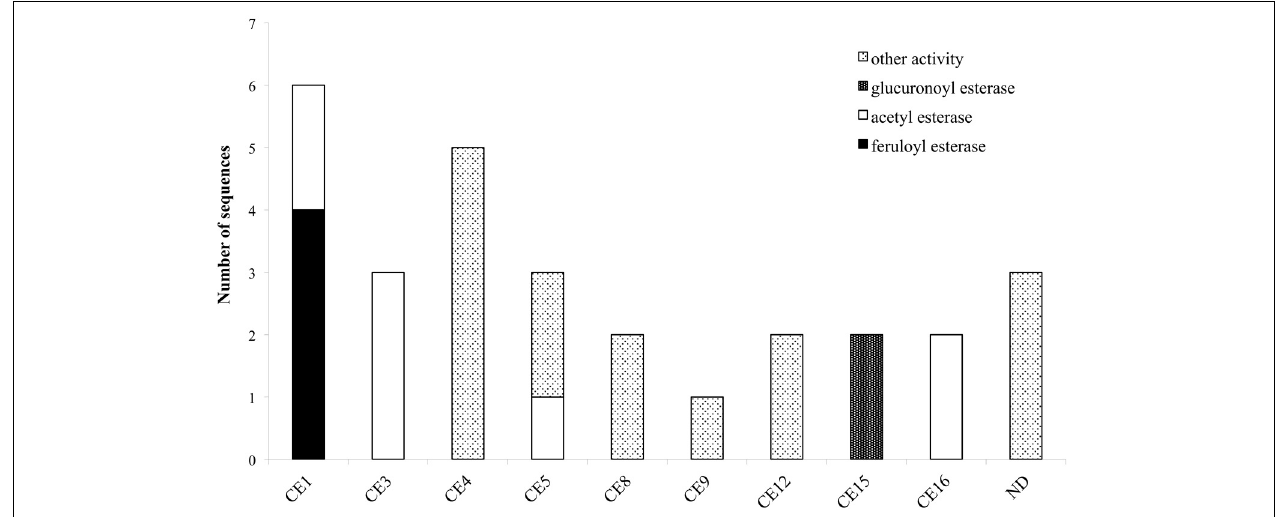
FIGURE 3 | Distribution of hemicellulolytic enzymes of M. thermophila throughout nine CE families. Family CE4 is comprised of putative proteins with polysaccharide deacetylase activity, CE5 of cutinases and